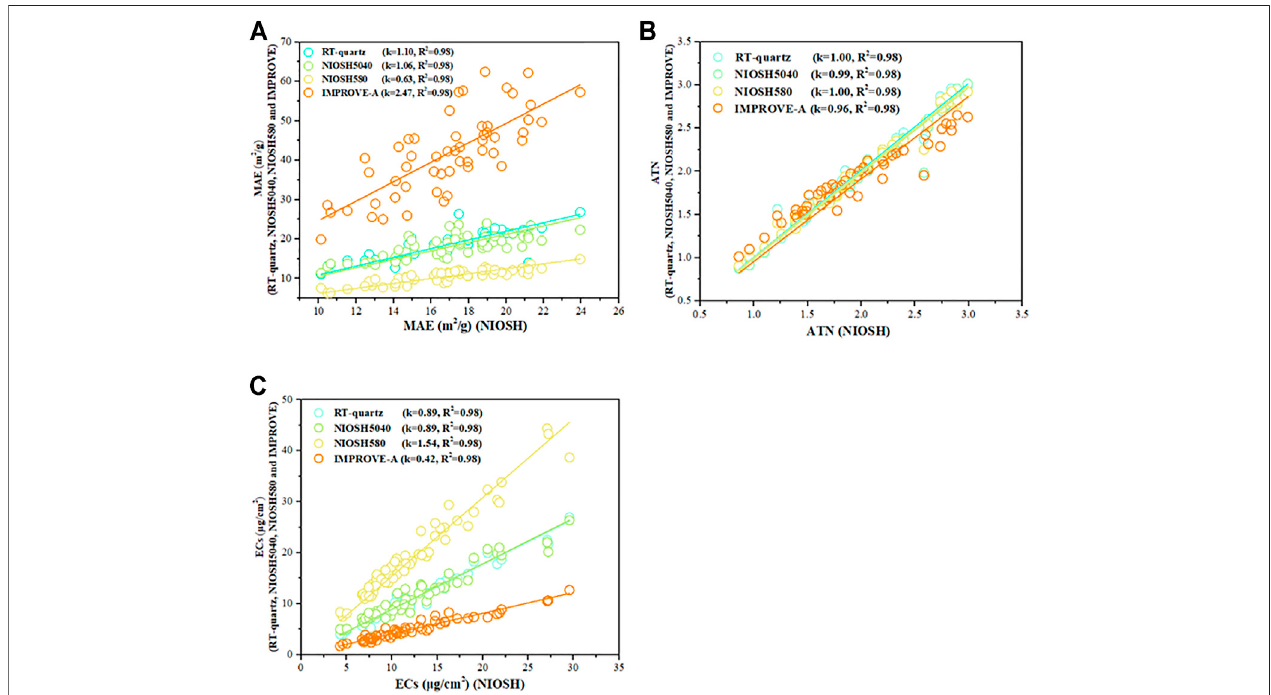
FIGURE 3 | Mass absorption ef fi ciency (MAE), optical attenuation (ATN), and elemental carbon (EC) mass by the National Institute for Occupational Safety and Health (NIOSH) protocol compared with those by RT-quartz, NIOSH5040, NIOSH580, and Interagency Monitoring of Protected Visual Environments (IMPROVE)-A protocols. (A) Comparison of MAE by different temperature protocols. (B) Comparison of light attenuation (ATN) by different temperature protocols. (C) Comparison of EC mass by different temperature